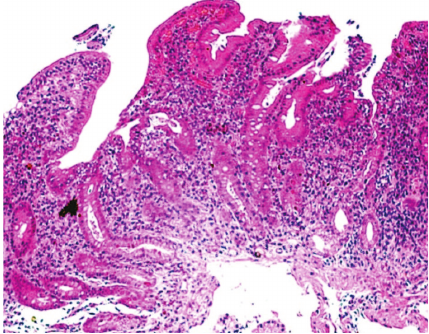
Figure 4: Histological analysis of the duodenal lesions revealed a decrease of goblet cells and severe chronic inflammation cryptitis without